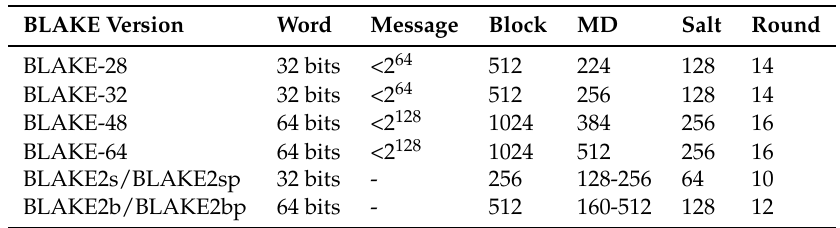
Table 2. Versions of BLAKE hash function.